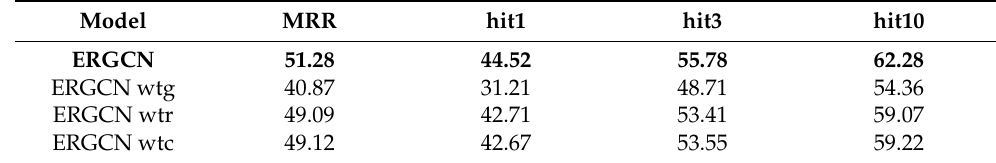
Table 4. Ablation studies on WIKI.